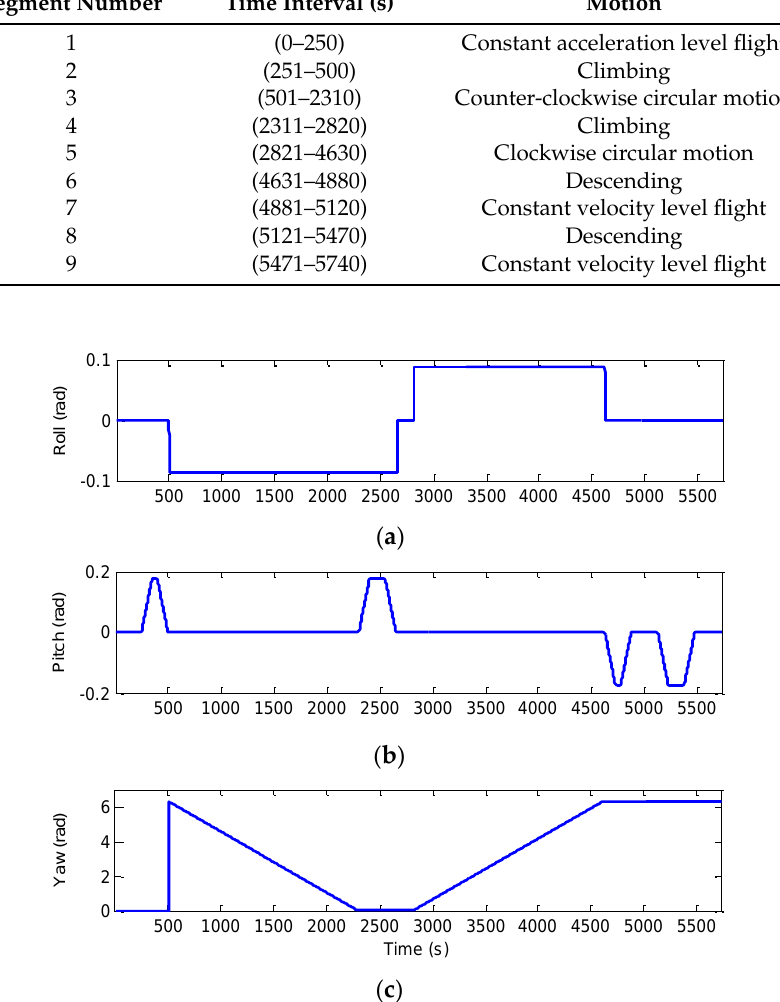
Figure 11. The Euler angles for the case of three-dimensional simulation. ( a ) Roll angle; ( b ) Pitch angle; ( c ) Yaw angle.